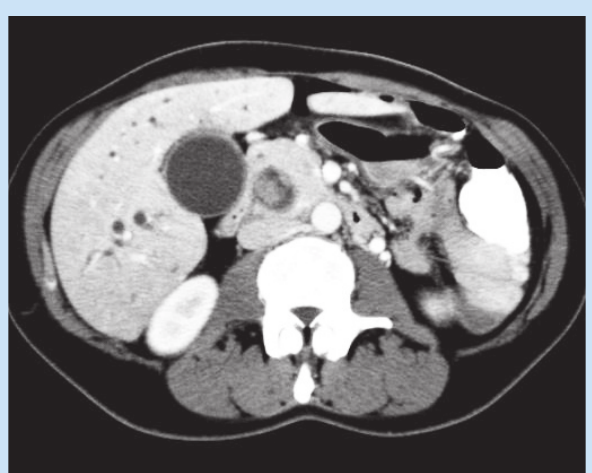
Fig. 2. Abdominal CT in the portovenous phase demonstrating a distended gallbladder, severe intra/extra hepatic bile duct dilatation and a lobulated, enhancing mass in the distal common bile duct in keeping with a cholan-